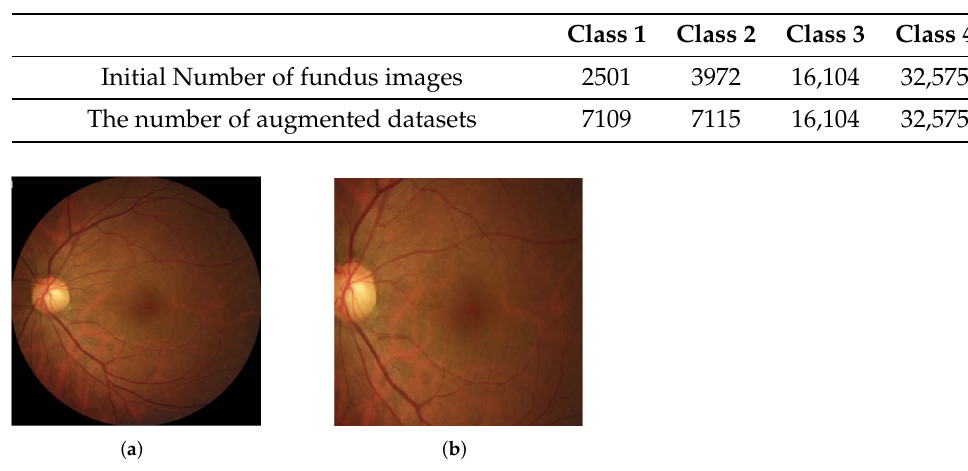
Table 4. The number of augmented datasets.